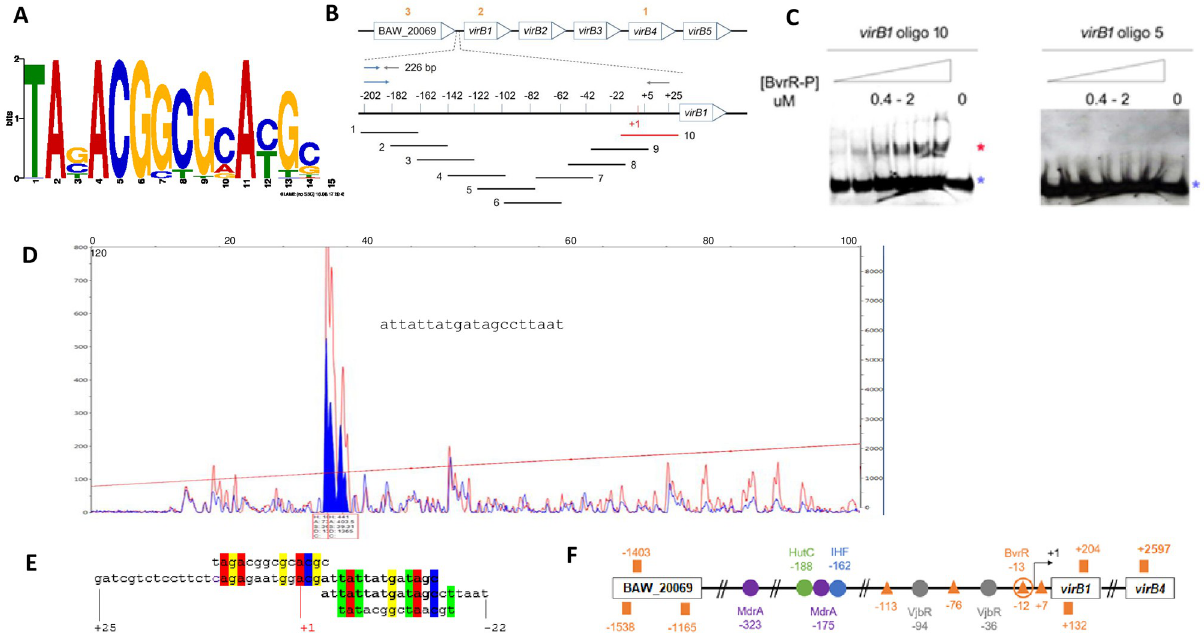
Fig 5. Location of the DNA binding motif recognized by BvrR-P in the promoter region of virB1 . A. DNA binding motif recognized by BvrR-P under conditions that mimic the intracellular environment obtained using GLAM2 for motif discovery within the significant ChIP-Seq signals dataset. B. Schematic non-scale representation of the virB operon and upstream gene BAW_20069. Orange numbers represent each of the three significant ChIP-Seq signals in this region. The zoomed area represents a 226bp virB1 upstream region, with a promoter region previously reported [42]. Red and black lines represent oligonucleotides that did and did not interact with BvrR-P by EMSA. C. EMSA results for the virB1 -oligonucleotides number 10 and 5. Red and blue asterisks represent the migration patterns of a protein-DNA complex (shift) and a free probe (no shift). D. Dnase I footprinting results using BvrR-P and the 226 bp DNA fragment encoding the virB1 promoter region. The traces are the Dnase I digested DNA fragments incubated with bovine serum albumin as control (red) or with BvrR (blue). Blue-filled peaks represent the Dnase I-protected region inferred according to [43]. The panel includes the DNA sequence obtained after Sanger sequencing. E. Sequence alignment between two configurations of the DNA binding motif (first and last line) derived from the motif shown in Fig 5A, the virB1 -oligonucleotide 10 (second line), and the Dnase I-protected region (third line). F. BvrR-P binding sites in the virB regulatory region. The orange squares represent the location of ChIP-Seq signals obtained in this study. The orange triangles represent the location of regions with percentages of sequence similarity to the DNA binding motif shown in A, ranging from 50 to 71.43%. The orange circle represents the BvrR-P binding site confirmed by EMSA and DnaseI footprinting. The colored circles (purple, green, blue, and gray) represent the binding sites for other transcription factors described to regulate the expression of the virB operon [80]. Number coordinates are relative to the transcription start site (black arrow). These results are representative of at least three independent